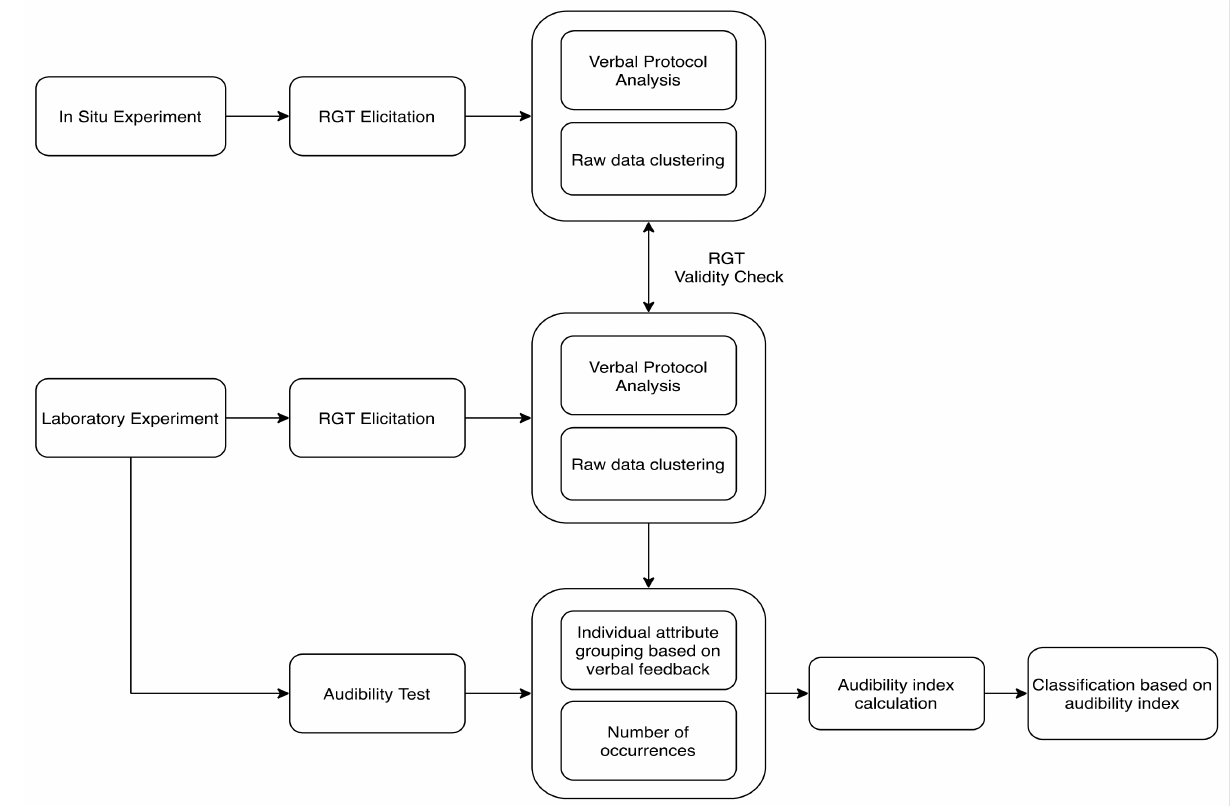
Figure 4. Data analysis